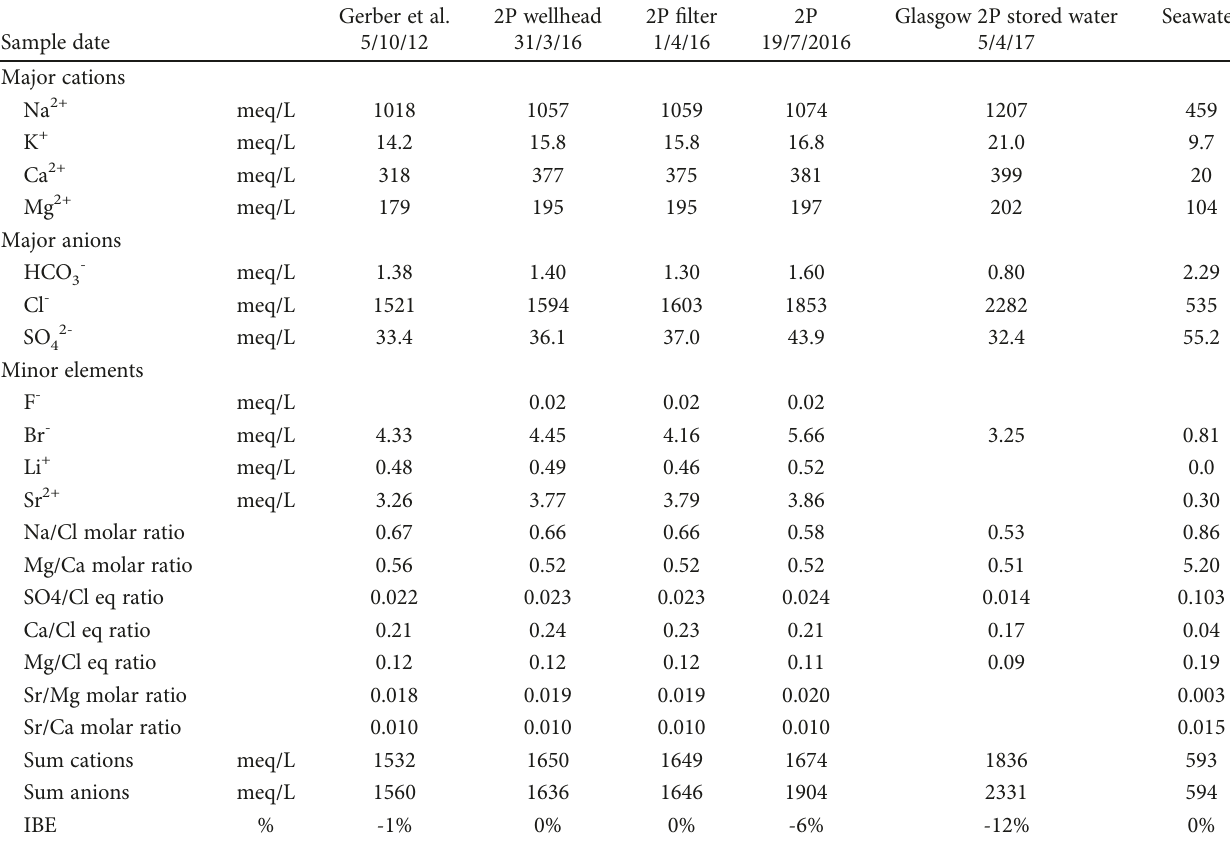
Table 4: Analyses reported in Table 3, converted to milliequivalents per litre (meq/L) and molar